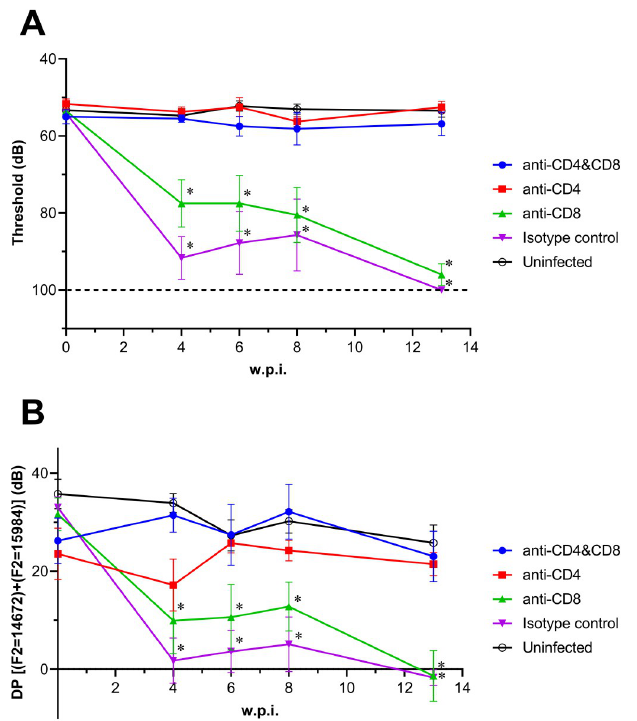
Fig 4. Hearing tests in T-cell-depleted mice infected with LASV. The results of ABR (A) or DPOAE (B) of LASV- infected Stat1-KO depleted with CD4 and/or CD8 T-cells were plotted. Data were shown using the mean and SEM. The broken line indicates the limit of detection in ABR (98 < dB). Statistical differences at each time point compared to each uninfected group were calculated by 2-way ANOVA followed by Dunnett’s post hoc test, and shown in asterisks (p <